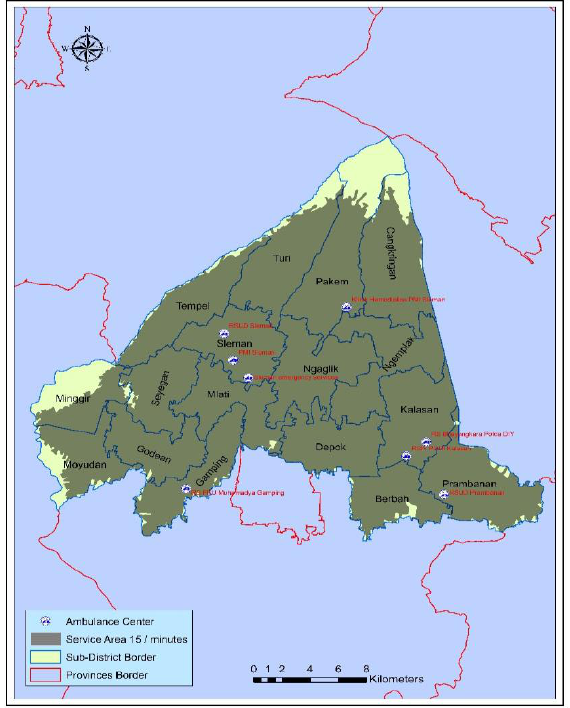
Figure 3. The service area of Ambulance centres in the study area based on the Time Standard (15 minute) The 8 ambulance centers in the study area cover an area of 523.14 square km and by 91%. The area outside the ambulance service reached 51.11 km2 (8.9%). These areas are located in separate places. The reason for not covering it is because there are road obstacles or incomplete roads. In addition, the inability of the ambulance to reach that area according to the time standard of 15 minutes. Consequently, there are deficiencies in covering these densely populated places, which necessitates reconsideration either by opening new ambulance centers, especially in the north and west, or working to open new roads that enable ambulances to reach them within the specified